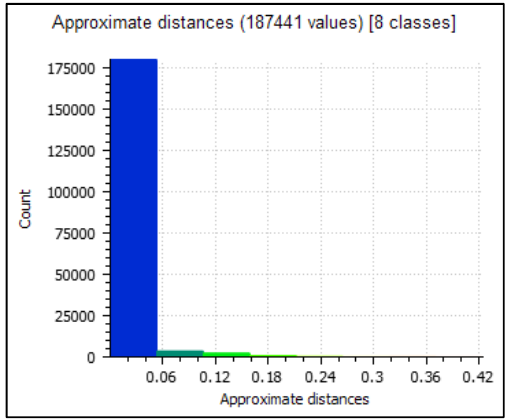
Figure 12: Discrepancy histogram between the TLS cloud and UAV VisualSfM processing.